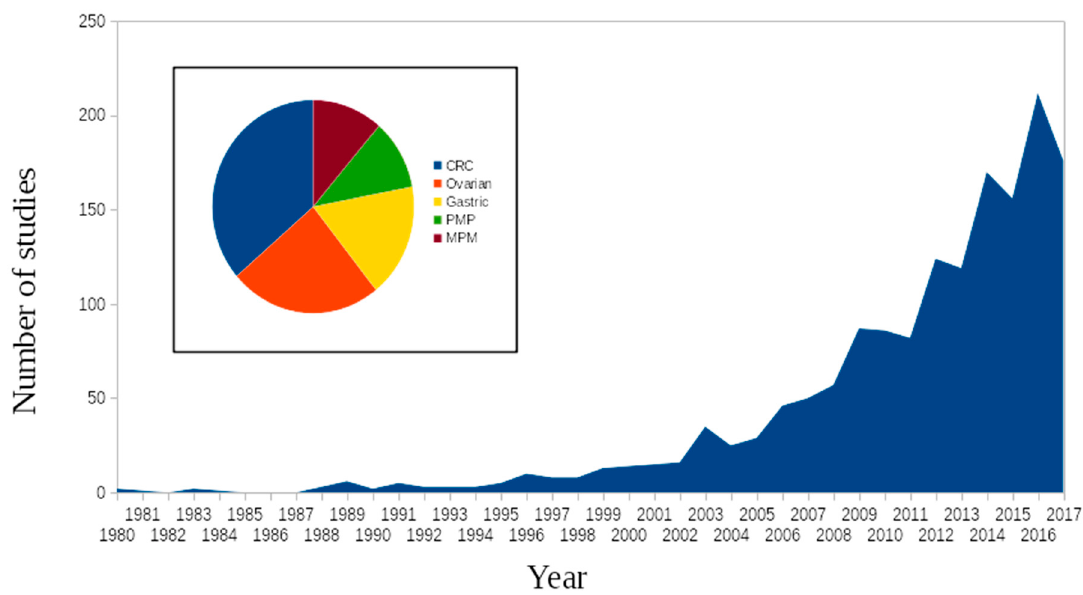
Figure 1. Number of studies published “hyperthermic” and “peritoneal” and “chemotherapy” on PubMed. Pie chart showing the distribution of each cancer origin of all included papers in this review.